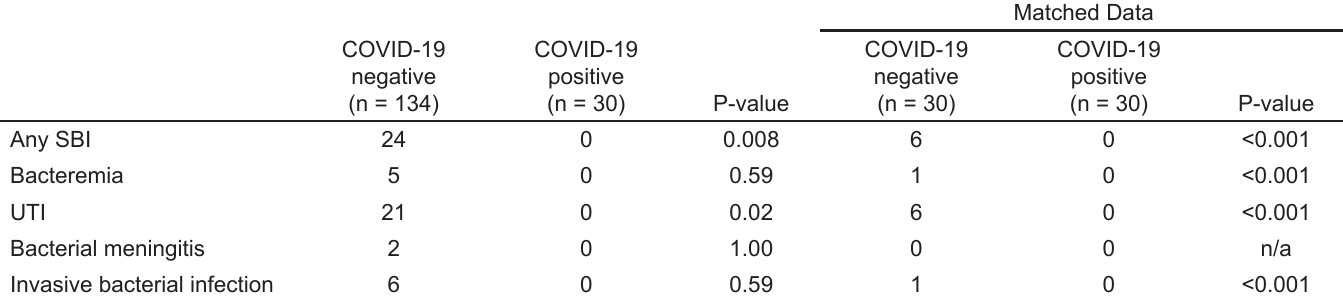
Note: The variables are summarized with each count. For the unmatched data, the groups were compared using Fisher’s exact test. For the matched data, the groups were compared using McNemar’s test.